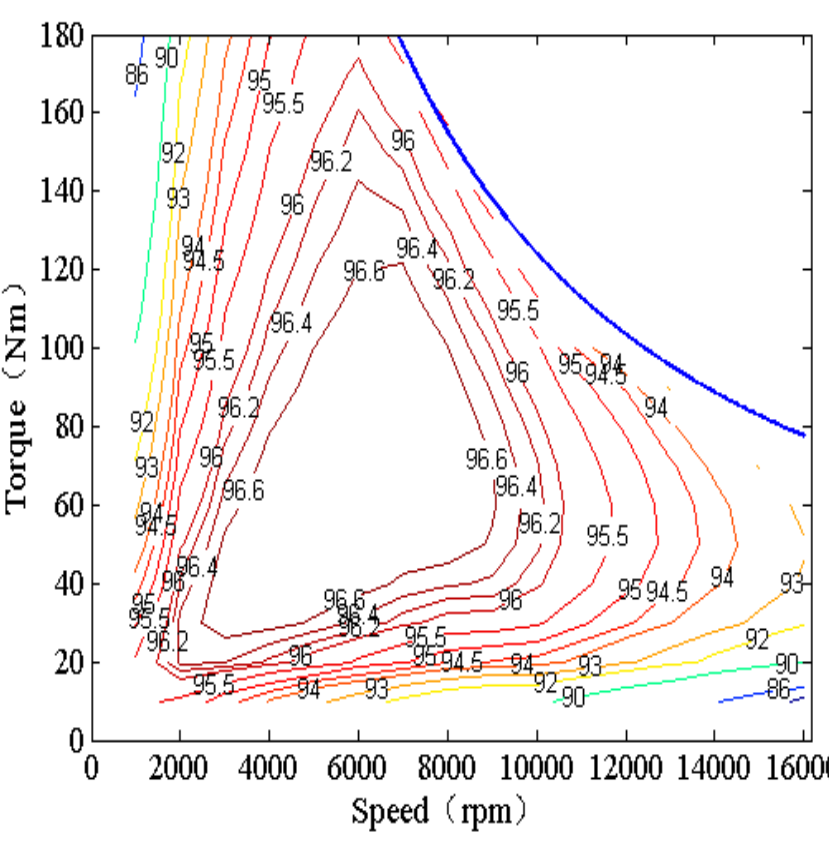
Figure 15. Efficiency map of V + 1-shaped rotor.